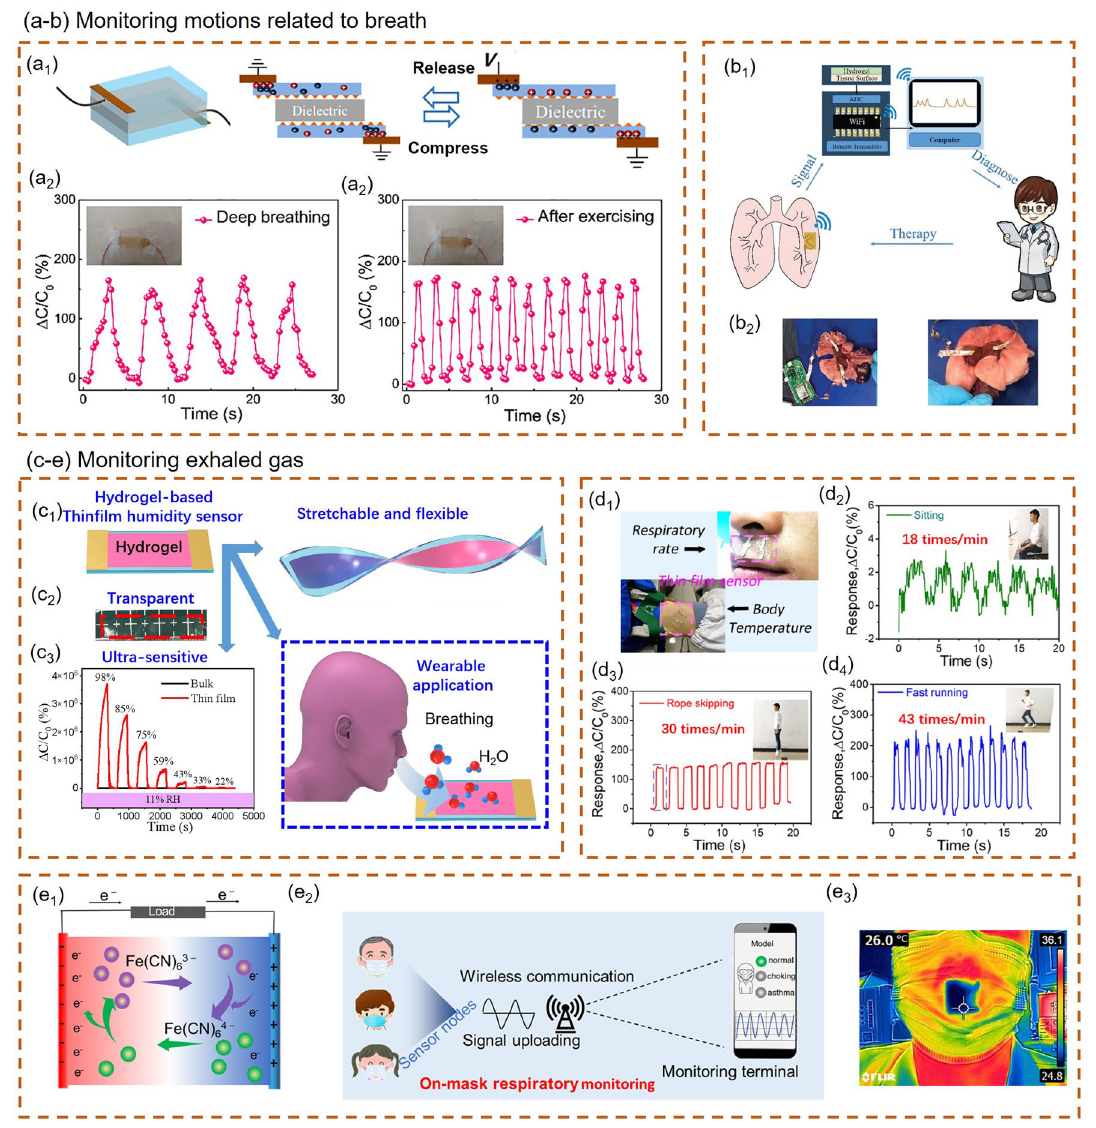
Fig. 8 Composite hydrogel-based wearable respiratory monitoring. a , b Respiratory monitoring method by attaching hydrogel sensors to the surface of the chest cavity or lung for monitoring [161, 163]. a 1 Schematic diagram of as-assembled capacitive pressure sensor. a 2 , a 3 The sen- sor is attached to the wearer’s abdomen to record the change of capacitive signal during deep breathing and breathing after exercise. Reproduced with permission. Copyright 2021, Elsevier. b 1 The respiratory monitoring data collected by the hydrogel patch is transmitted to the computer through a wireless transmitter for subsequent processing and analysis. b 2 The respiratory signal is recorded by a hydrogel sensor attached to the rabbit lung and transmitted through wired (left) and wireless (right) communication. Reproduced with permission. Copyright 2014, Royal Soci- ety of Chemistry. c – e Respiratory monitoring method by monitoring exhaled gas [26, 165, 166]. c 1 PAM/CA hydrogel film humidity sensor. c 2 The white marks below can be seen through the PAM/CA hydrogel film, which proves the excellent transparency of the hydrogel film. c 3 Com- parative studies showed that the responses of these sensors are thickness dependent. Thin film hydrogel sensor has higher sensitivity than bulk hydrogel. Reproduced with permission. Copyright 2022, Springer Nature. d 1 TFSS sensors are attached to the skin of the upper lip and wrist, respectively. d 2 – d 4 Capacitance changes of sensor during sitting, rope skipping and fast running, respectively. Reproduced with permission. Copyright 2021, American Chemical Society. e 1 Thermoelectric conversion mechanism of PVA/GEL thermogalvanic hydrogel. e 2 Schematic diagram of on-mask respiratory monitoring system. e 3 Infrared image of the wearing mask showing a visual Δ T between the gel sensor in the mask and ambient. Reproduced with permission. Copyright 2022, American Chemical